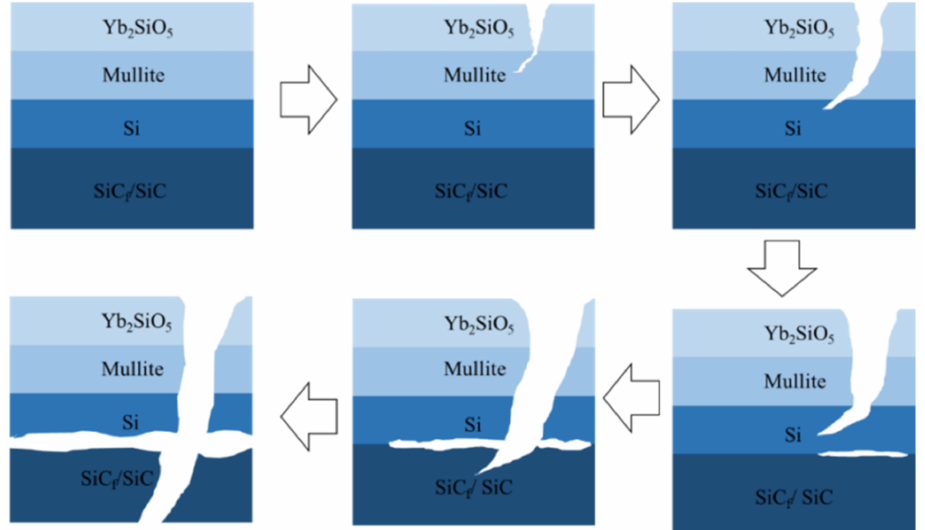
Figure 11. Schematic diagram of the failure mechanism of the specimen with the EBC after the thermal mechanical coupling